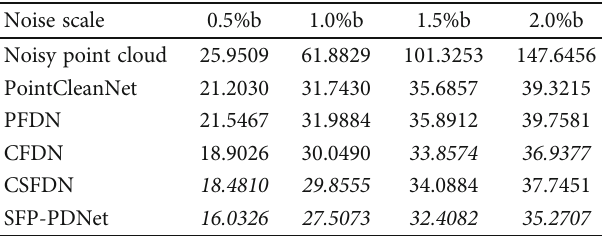
Figure 28: The larger versions of the assembly position of casing 1-7 (a) and (b), casing 8 bosses (c) and (d), casing 10 bosses (e) and (f). Left (SFP-PDNet) Right (PointCleanNet). Table 3: Quantitative comparison of di ff erent networks (CD between denoised point clouds and clean point clouds).